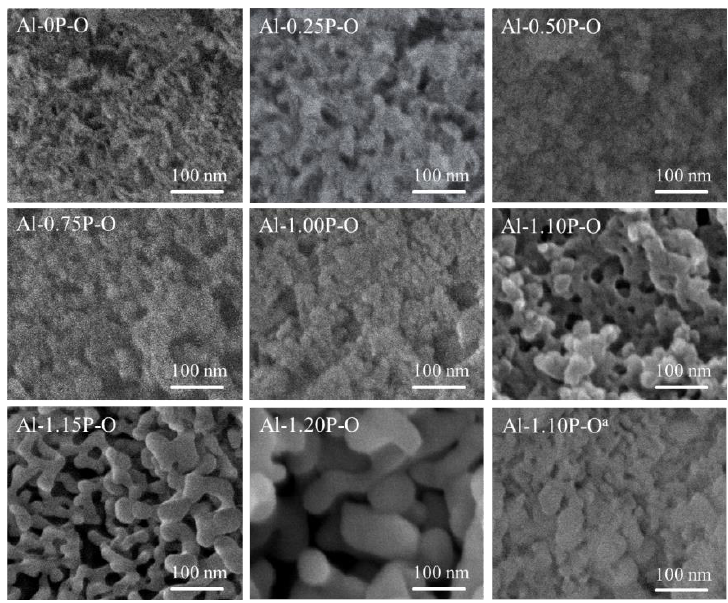
Figure 3. SEM images of Al- x P-O and Al-1.1P-O a samples. FT-IR spectra of Al- x P-O samples are presented in Figure 4. All the tested samples had obvious vibration signals at 3470 cm −1 and 1634 cm −1 , which were attributed to the stretching vibration the O-H bond and bending vibration of physically adsorbed water, respectively [24,33 – 35]. All samples except Al-0P-O had vibration signals at 1139cm −1 , 730 cm −1 and 490 cm −1 . The vibration signal at 1139 cm −1 could belong to the asymmetric stretching vibration of the P-O bond in the (PO 4 ) 3 − tetrahedron. The vibration signal located around 490 cm − 1 was attributed to the bending vibration of O-P-O in the (PO 4 ) 3 − tetrahedron. The vibration signal around 730 cm −1 was assigned to the vibration of Al-O bond combined with P-O bond [27,31,36,37]. When x ≤ 1.1, Al- x P-O samples had a weak vibration signal near 730 cm −1 , this indicated that Al- x P-O samples ( x < 1.1) had an amorphous aluminum phosphate structure instead of a simple mixture of Al 2 O 3 and P 2 O 5 . When x > 1.1, the vibration signal of the Al- x P-O samples at 730 cm −1 was significantly enhanced. This strong vibration signal should be caused by the formation of crystalline aluminum phosphate phase, which is consistent with the results of XRD characterization.